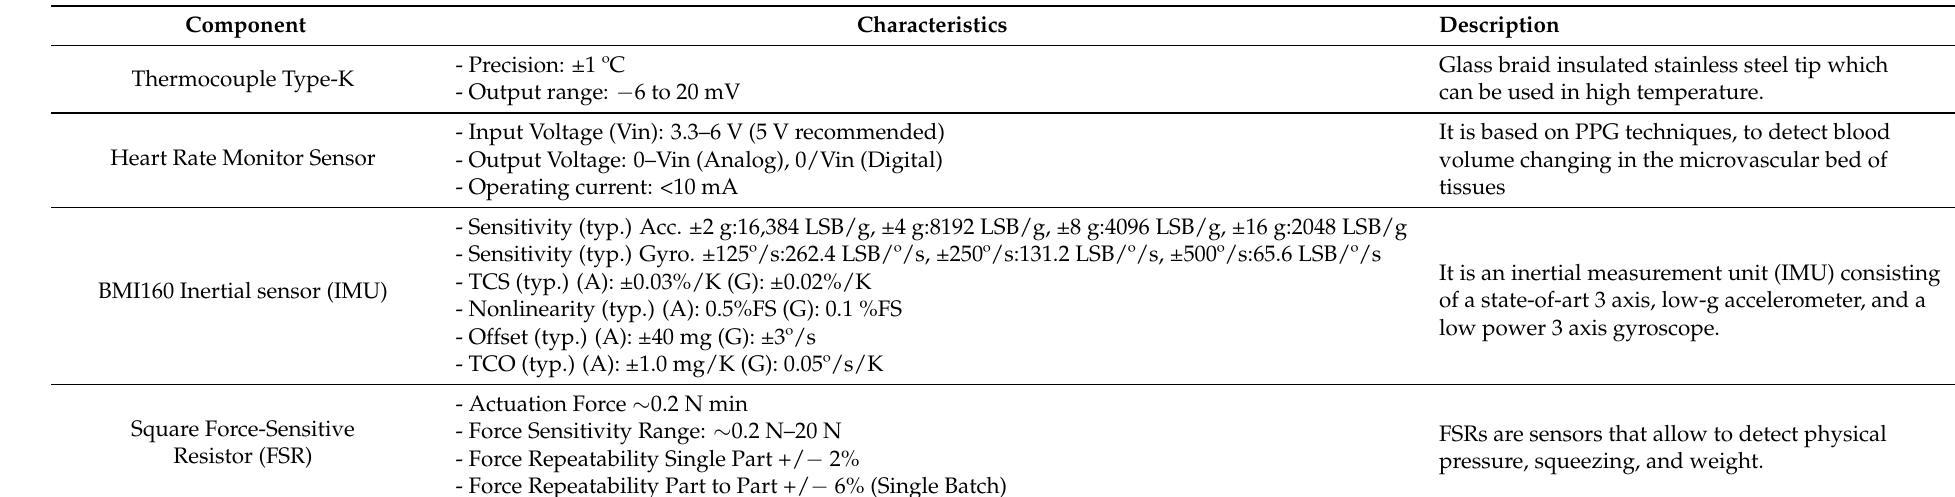
Table 3. Technical specifications of the sensors selected for the